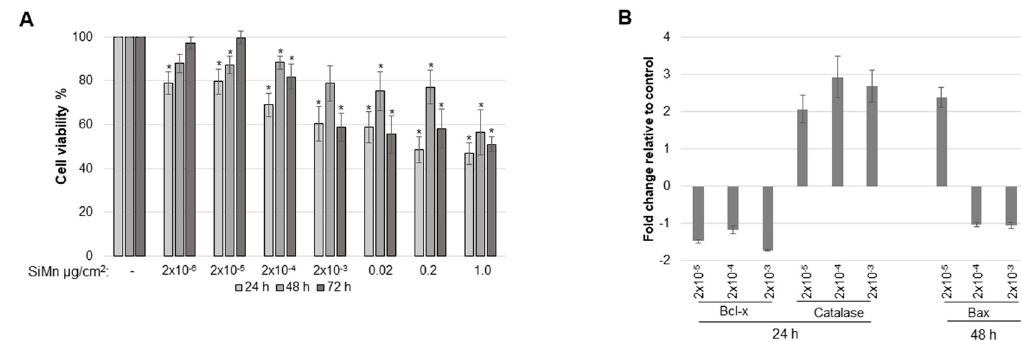
shown in the bar graphs. A fold increase or decrease of 1.5 was set as cut-off and only the results for those proteins are shown. Error bars: standard error (SE).